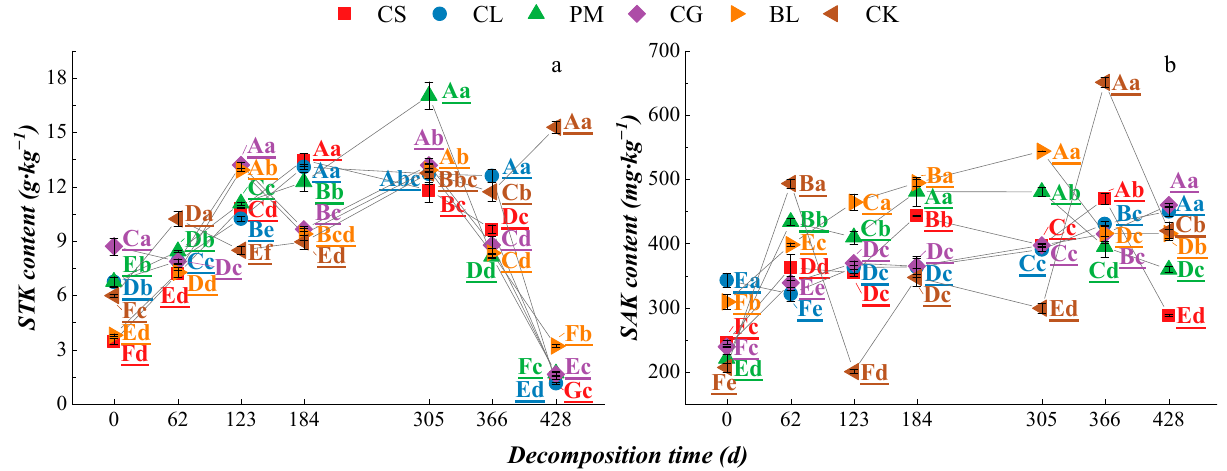
Figure 9. Dynamic changes in soil K content during the litter decomposition process (( a )-STK, ( b )-SAK). CS— Camellia sinensis , CL— Cunninghamia lanceolata , PM— Pinus massoniana , CG— Cinnamomum glanduliferum , BL— Betula luminifera , CK—control; STK—soil total potassium, SAK—soil